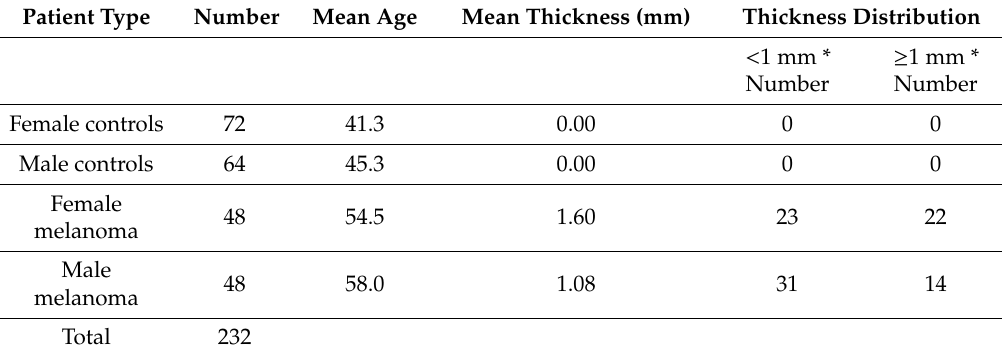
Table 1. Descriptive statistics of the population for the serum-expression